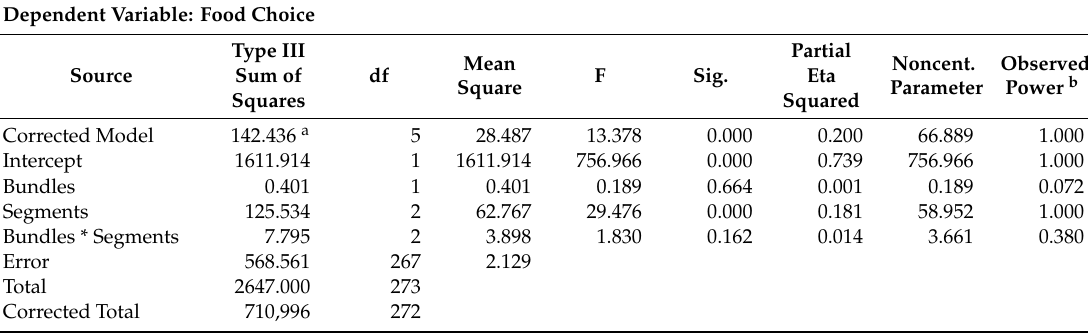
Table E1. ANOVA tests results on Food choice as a function of Bundles and Segments.